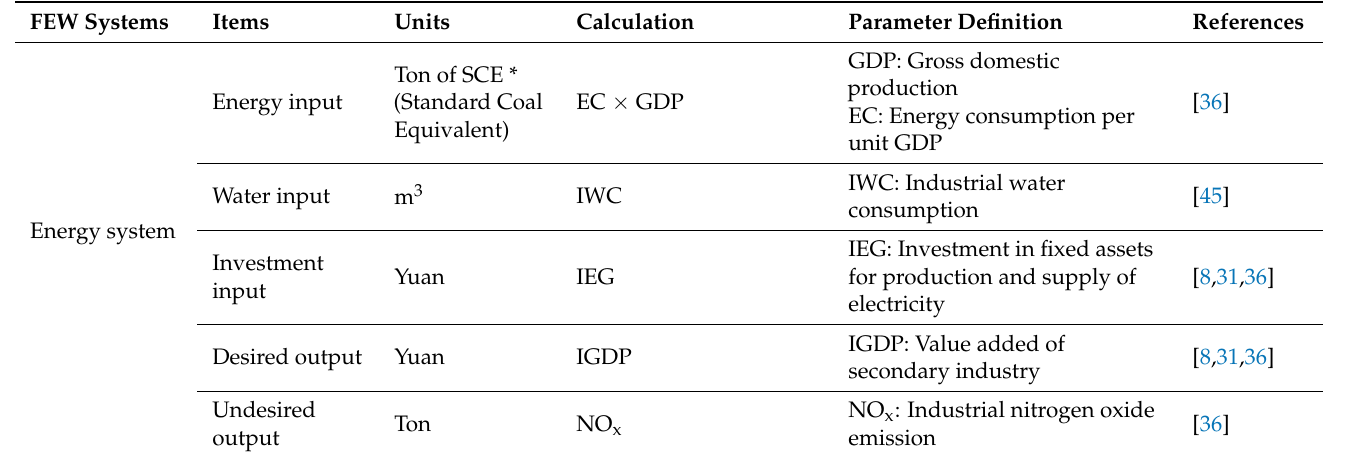
Table 2. The outline of the input and output indicators for urban FEW efficiency assessments.